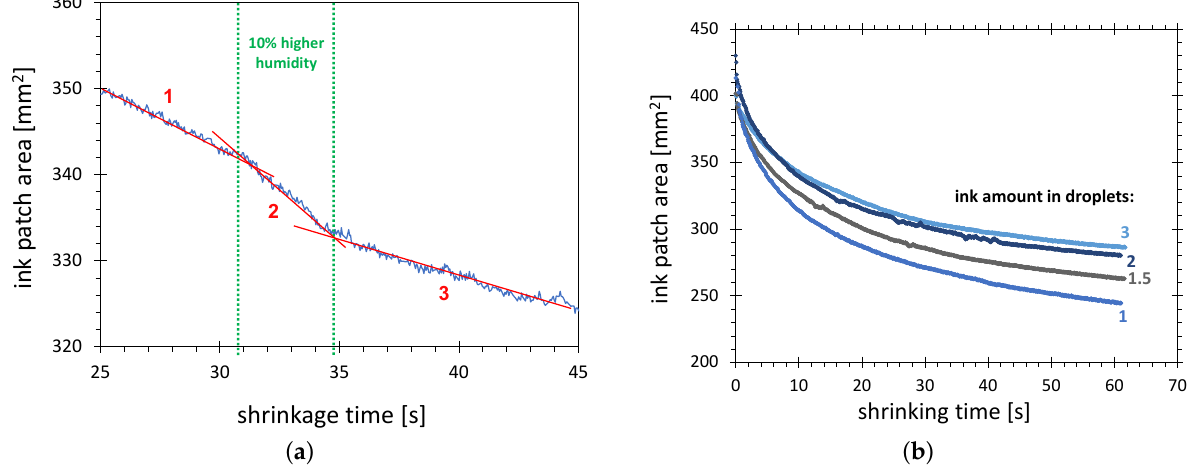
Figure 7. Shrinkage characteristics of the 58 mN/m test ink patch on HDPE plasma-treated in configuration C. ( a ) The segment showing the influence of increased air humidity; ( b ) The influence of the different amounts of applied